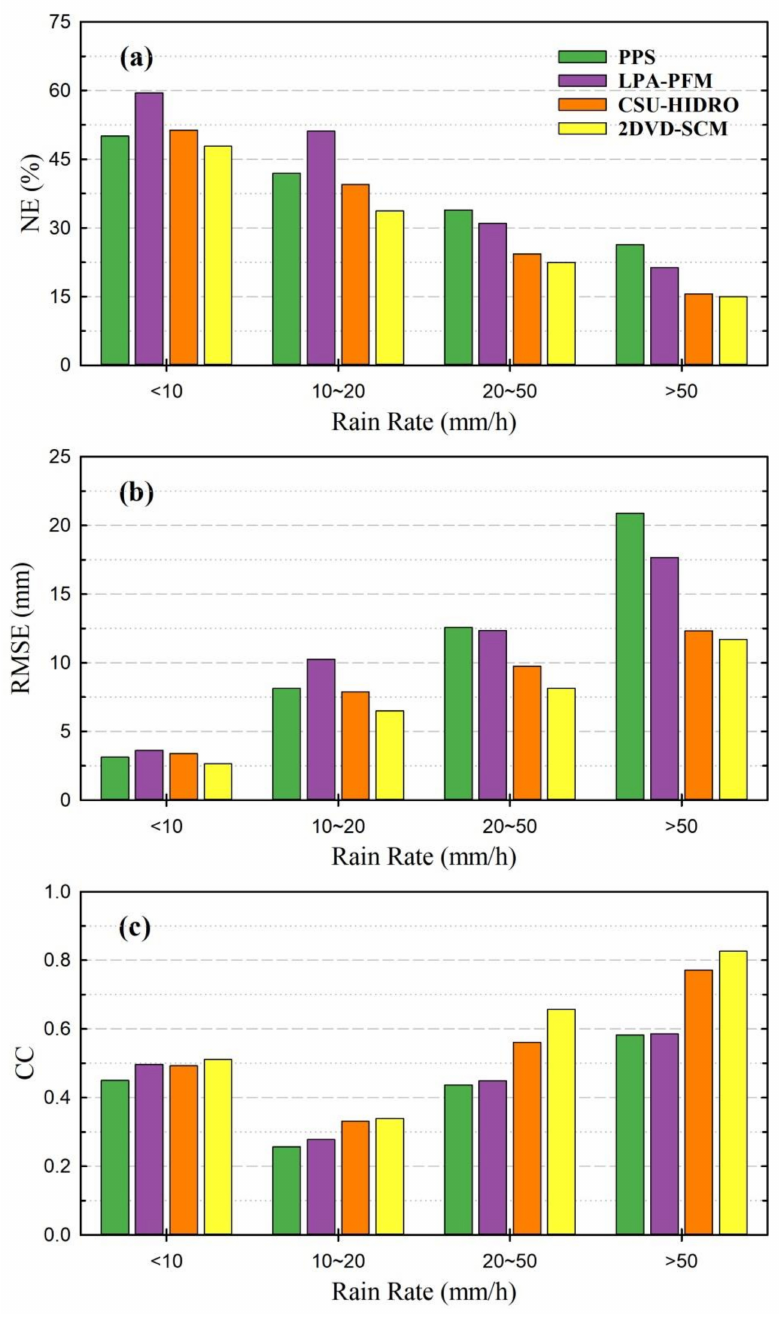
Figure 10. Bar graphs show ( a ) NE (%), ( b ) RMSE (mm/h), and ( c ) CC (non-dimensional) ob- tained from QPE algorithms of PPS, LPA-PFM, CSU-HIDRO, and 2DVD-SCM for different hourly accumulation classes in all eight rainfall